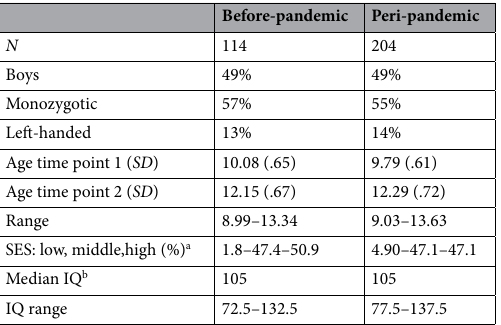
Table 1. Demographic characteristics for each pandemic group. N number of participants, SD standard deviation. a Socio-economic status (SES), based on parental education at wave 1. b Intelligence quotient (IQ), based on subtests “similarities” and “block design” of the WISC (3rd edition) at wave